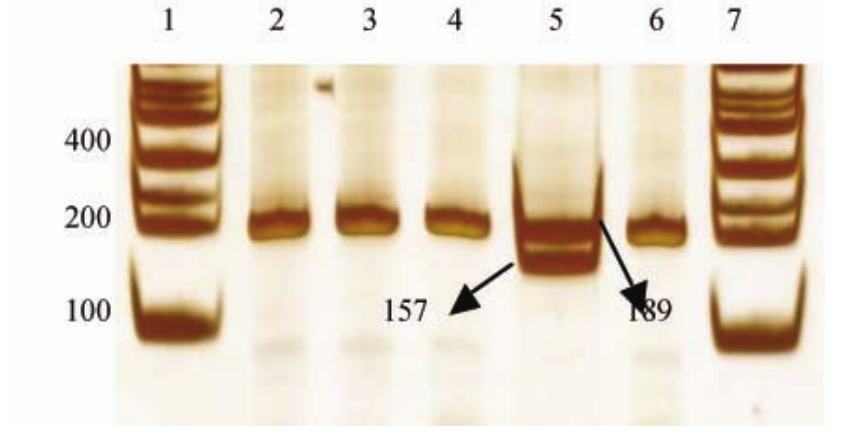
Figure 1. Genotypes of CCR 5 gene: Wild type and Heterozygous genotype, 12% PAGE. Lane 1 & 7: 100 bp DNA ladder. Lane 2-4 & 6: WT CCR5 gene (189 bp). Lane 5: Heterozygous CCR5 gene (189 bp + 157